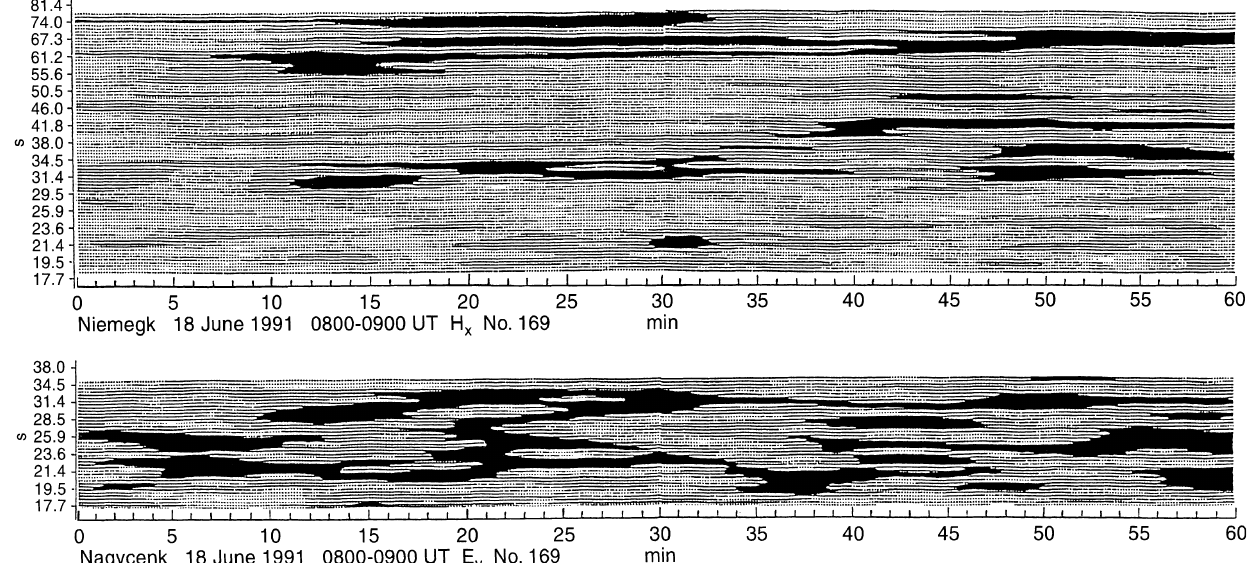
Fig. 10. Dynamic spectra of the 0800–0900 UT, 18 June 1991, event with increased frequency resolution at NCK and at NGK. Di(cid:128)erent symbols mean here amplitudes di(cid:128)erring by a factor of 2